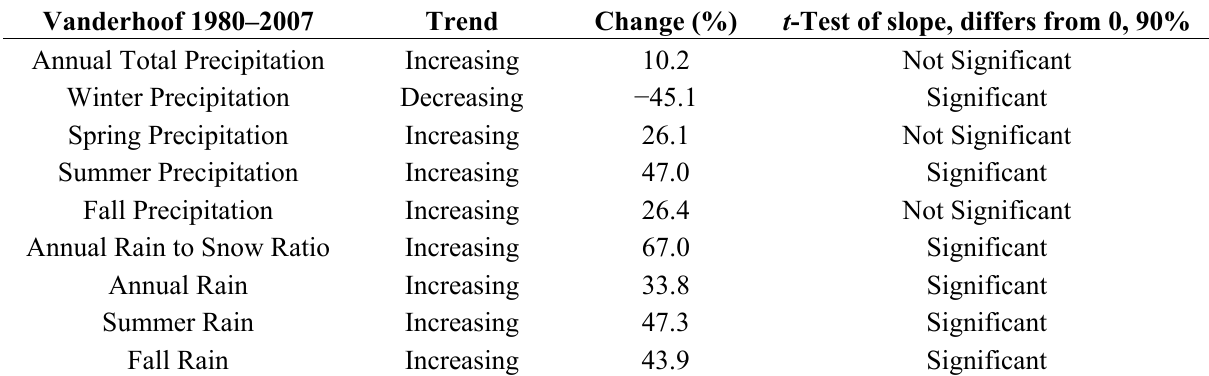
Table 4. Precipitation trends between 1980 and 2007 at the Vanderhoof climate